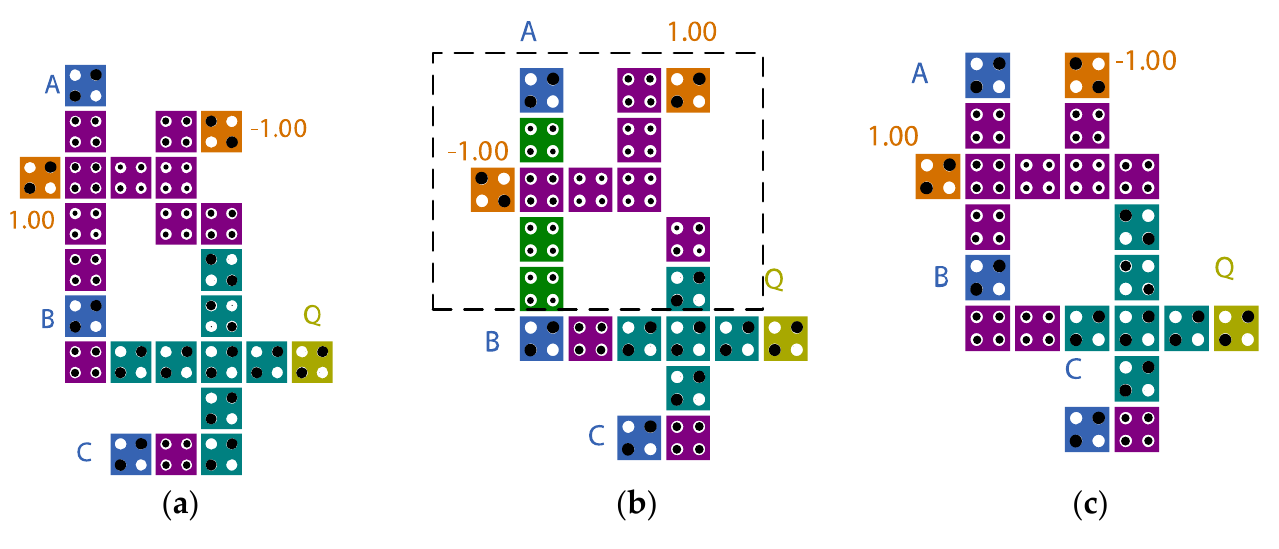
Figure 14. Layouts of the proposed 2-to-1 multiplexers: ( a ) 2-to-1 MUX1, ( b ) 2-to-1 MUX2, and ( c ) 2-to-1 MUX3 implemented by using the XOR in [5].